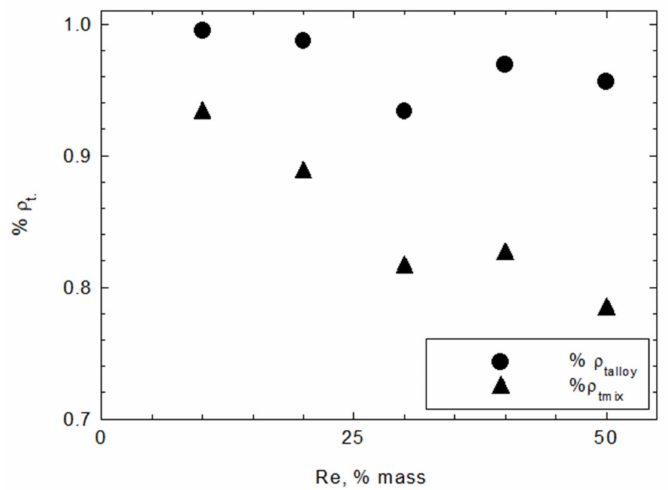
Figure 7. Ratio between measured density of Ni20Cr + xRe powders and values calculated based on mixture rule (mix) and additive effects of components in alloys